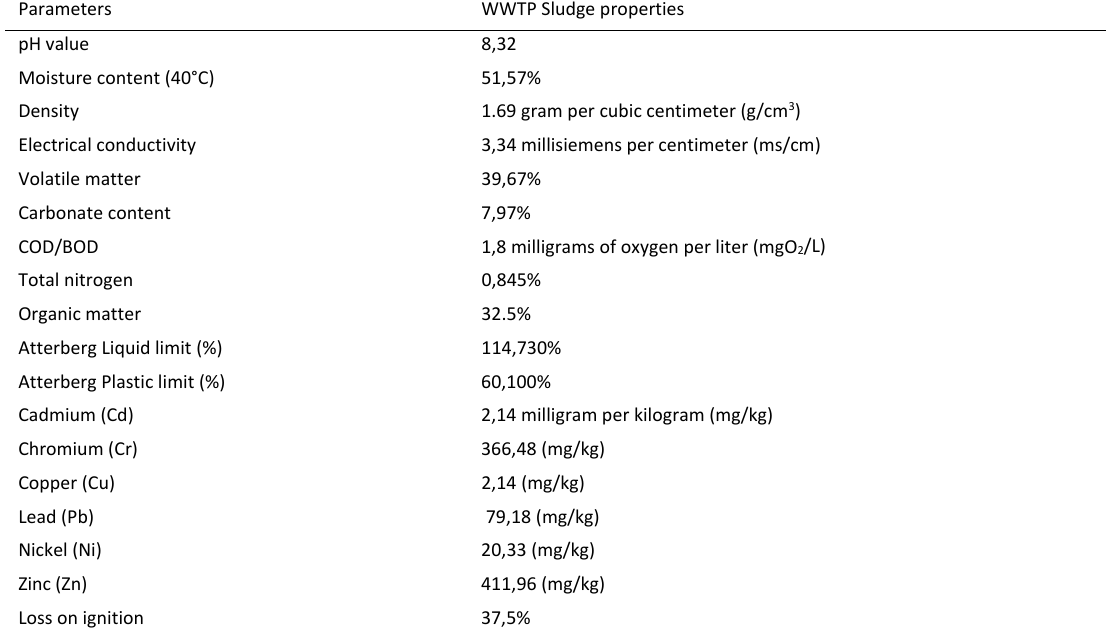
Table 1: The used wastewater treatment plant sludge properties and composition